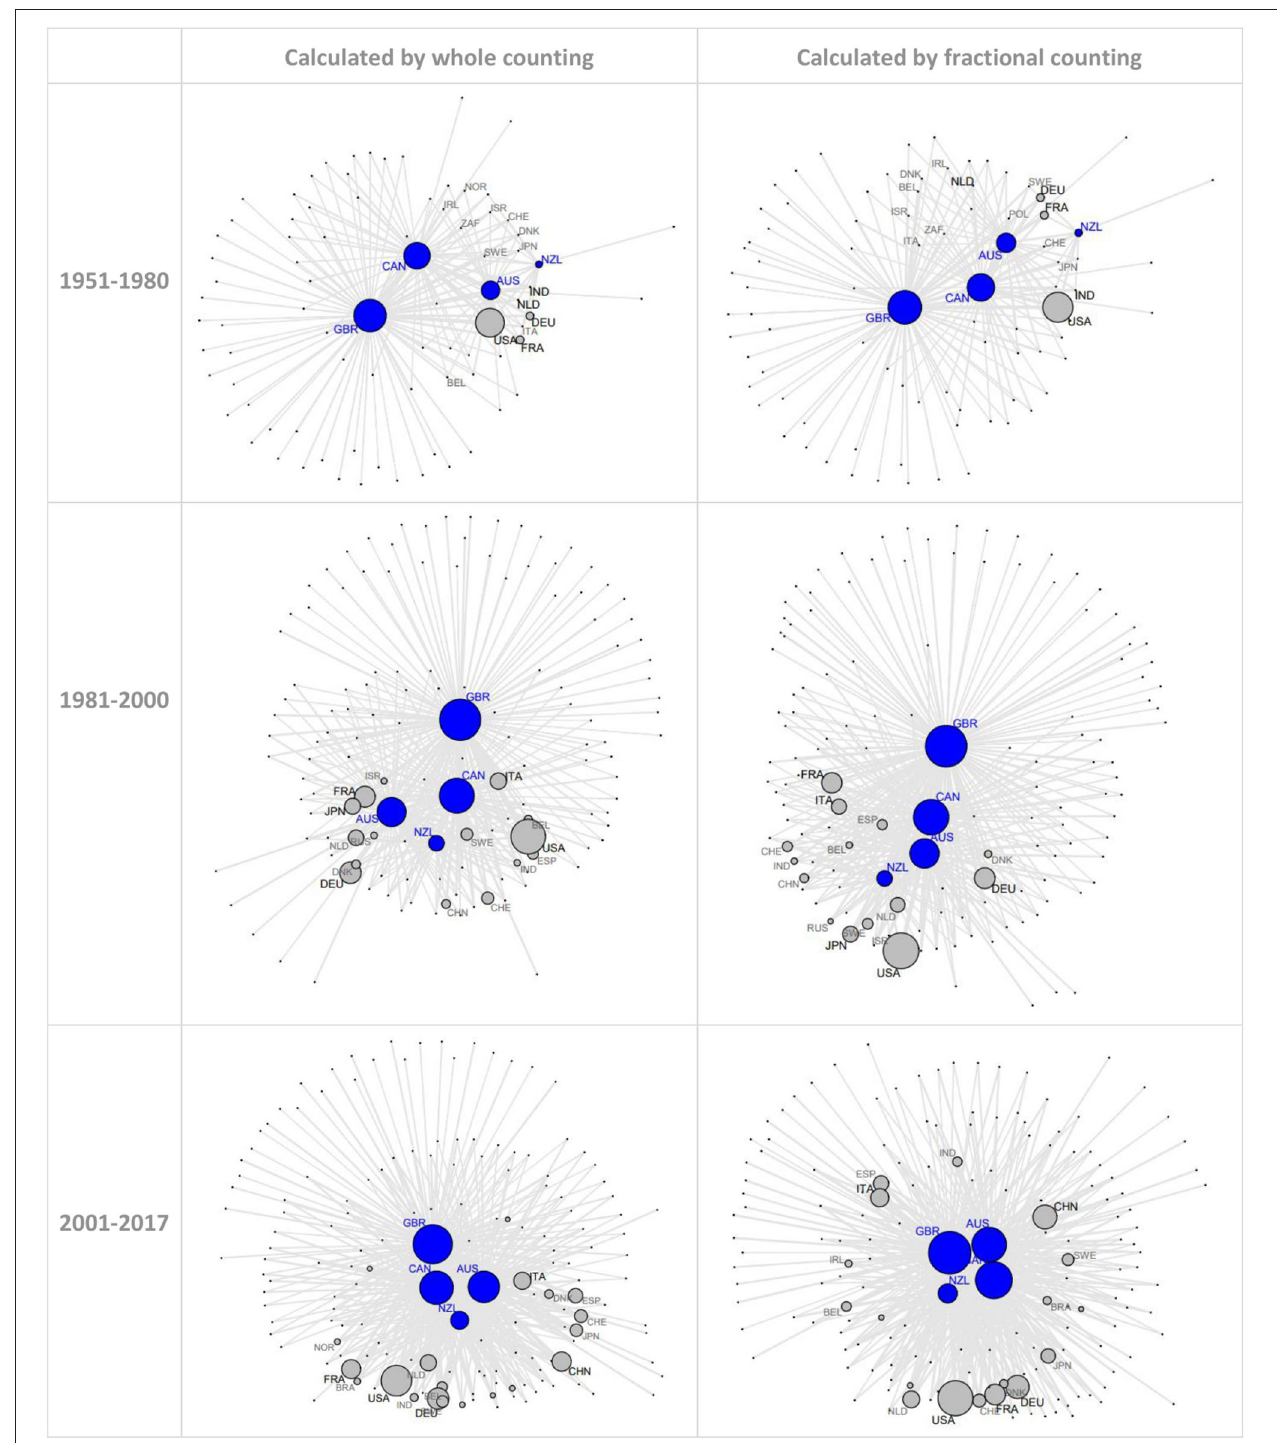
FIGURE 1 | Network maps of international co-authorship relationships relating to CANZUK countries in three periods: 1951–1980, 1981–2000, and 2001–2017 (top 15 collaborative countries and the CANZUK countries were labeled: the top 5 in black and the next 10 in gray. CANZUK countries were labeled in blue). The number of research connections has increased over